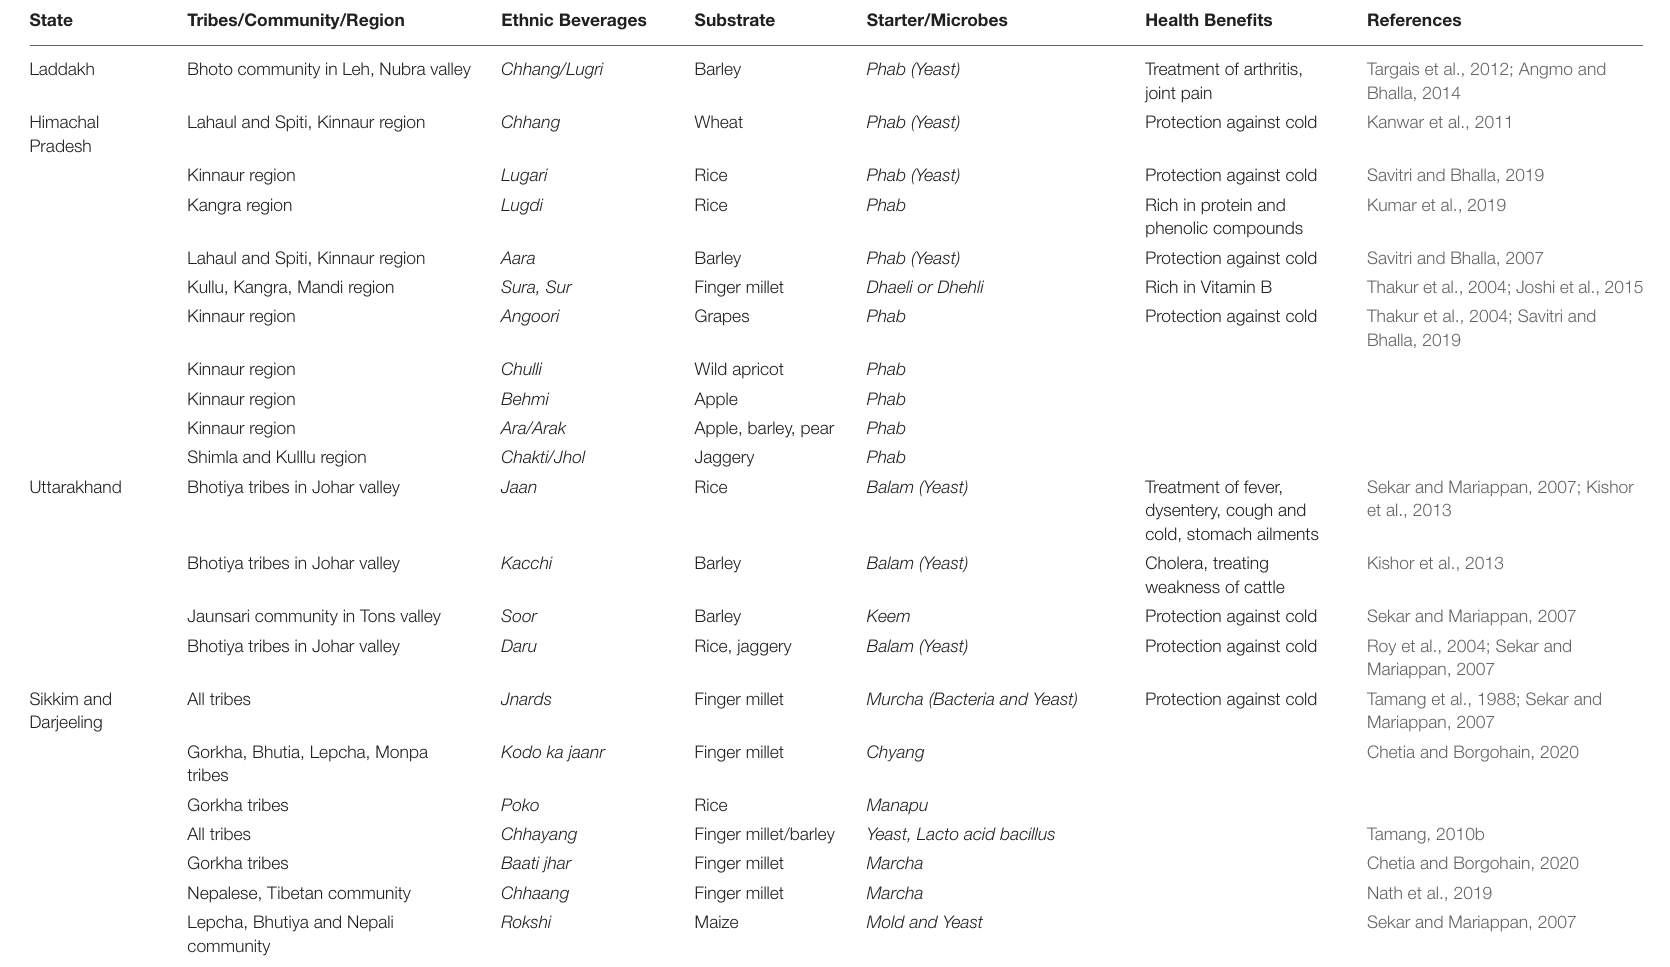
TABLE 1 | Description of ethnic alcoholic beverages and their use in the Himalayan